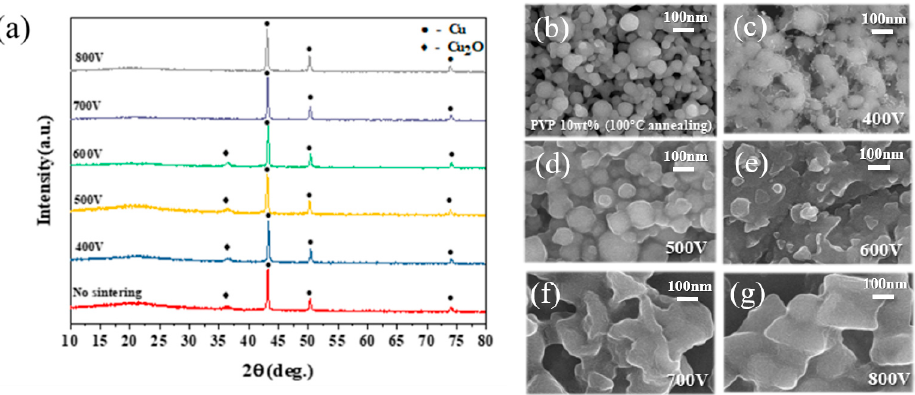
Figure 11. ( a ) XRD patterns of the ink-jet printed Cu conductive layer on photo-cured SiO 2 insula- tion layer after the IPL sintering process and FE-SEM images; ( b ) no sintering; ( c ) 400 V; ( d ) 500 V; ( e ) 600 V; ( f ) 700 V; and ( g ) 800 V.